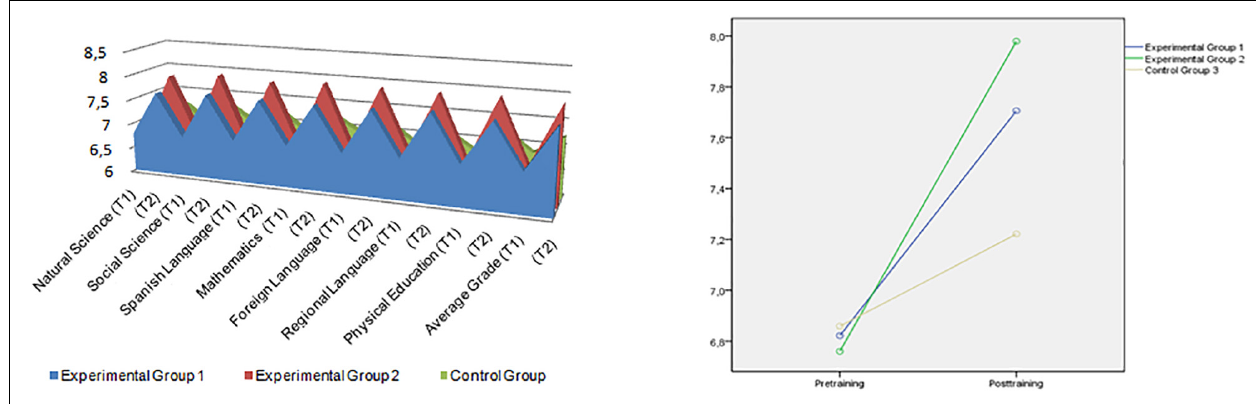
FIGURE 1 | Changes by subject and average grade for group 1 (face-to-face methodology), group 2 (e-learning gamification methodology), and control group with the implementation of a 7-week training program and administration of two tests (before and after the